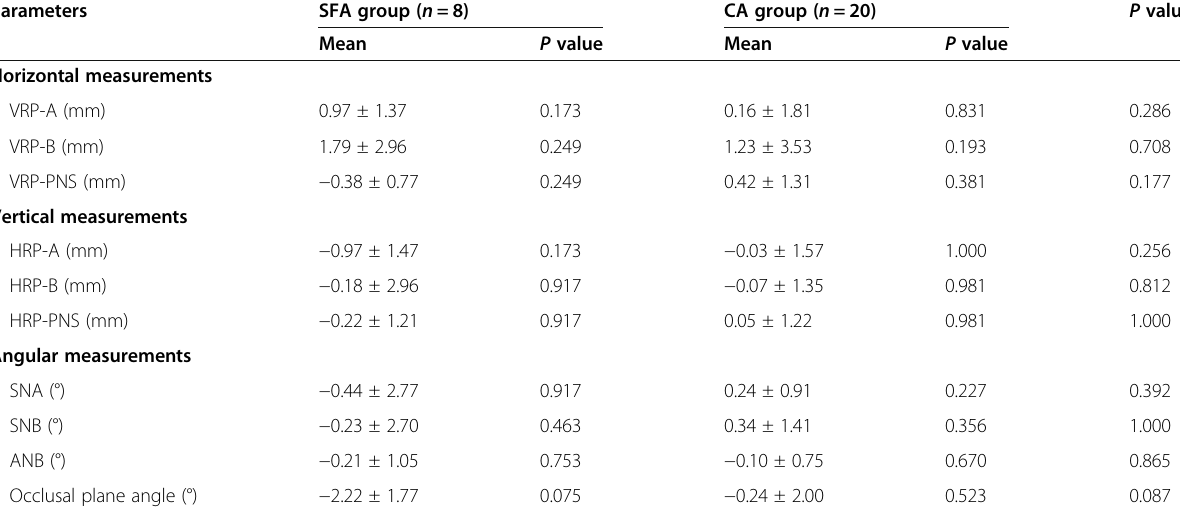
Table 5 Comparison of long-term result change (T4-T3) on Experimental group and Control group Parameters SFA group ( n = 8) Horizontal measurements